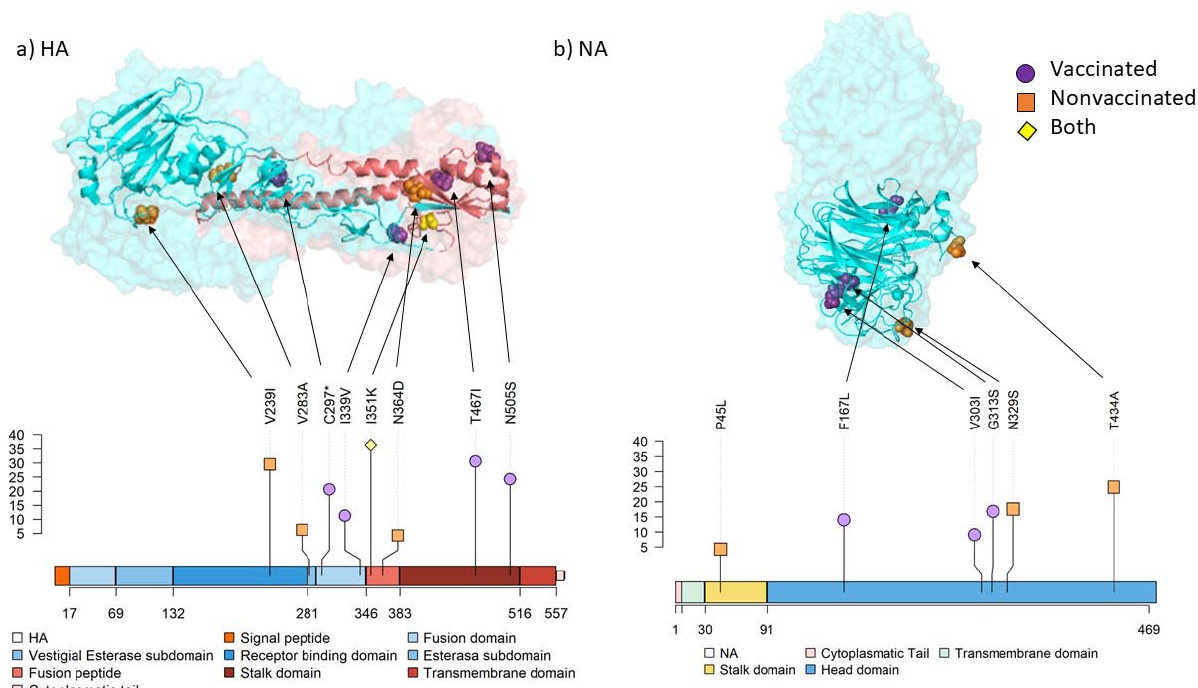
Figure 9. Location of substitutions with an allele frequency greater than 5% found in surface glycoproteins by both protein structure and lolliplot representation. The allele frequency is indicated on ordinate axis. ( a ) HA 3D trimer (PDB accession no. 7VDF) [51] and lolliplot domain representation. HA1 domains are represented in different tones of blues and HA2 domains in different tones of reds. ( b ) NA 3D tetramer head domain (PDB accession no. 4GZO) [52] and lolliplot domains representation. Substitution P45L from the stalk domain is not included in the limits of the crystalography structure used.